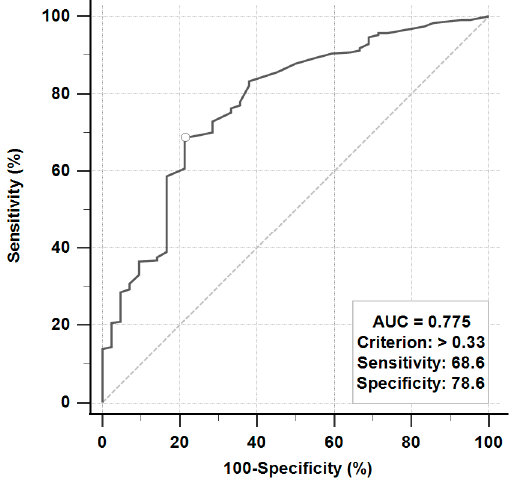
Figure 1. The receiver operating characteristic (ROC) curve to evaluate facial electroneurography for the prediction of favorable or unfavorable outcomes.